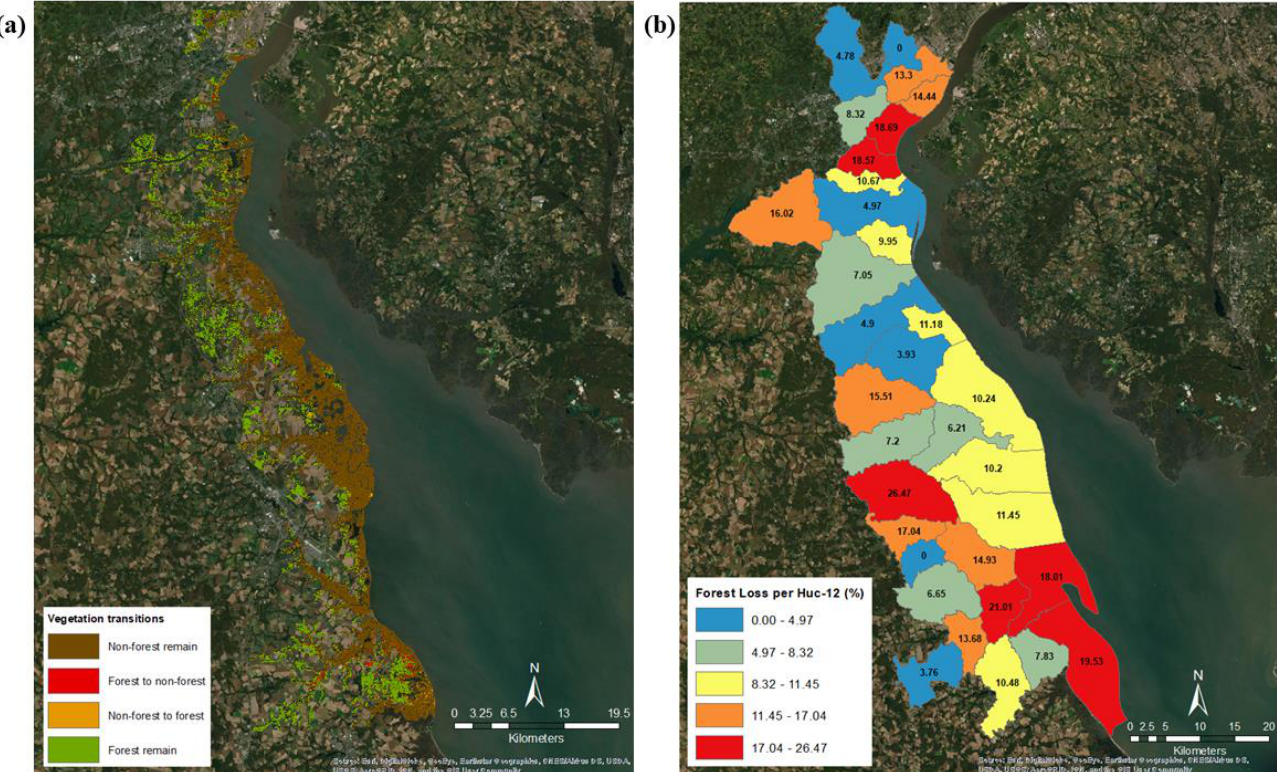
Figure 3. Change map of the study area from the post-classification analysis ( a ). Normalized area of forest loss per HUC 12 hydrologic subregion ( b ).